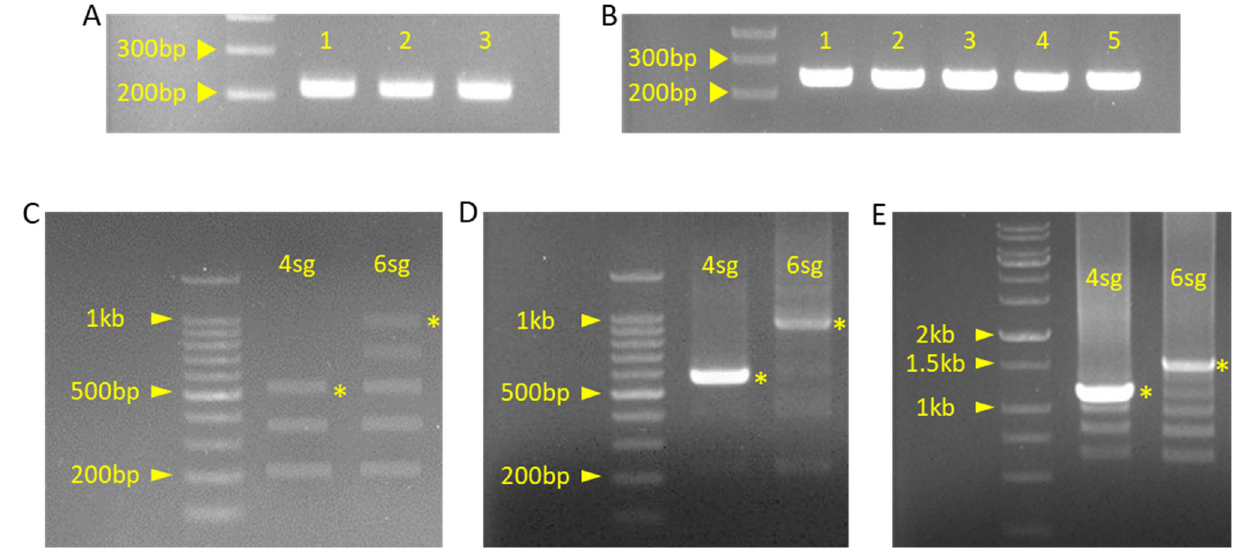
Figure 8. Gel picture of PCR or ligation products. ( A ) Product of insert fragment PCR for pBAtC_4sg construction. Each fragment number indicates a sequential order. 1: ‘g1g2’ primer set used fragment, 2: ‘g2g3’ primer set used fragment, 3: ‘g3g4’ primer set used fragment. ( B ) Product of insert fragment PCR for pBAtC_6sg construction. Each fragment number indicates sequential order. 1: ‘g1g2’ primer set used fragment, 2: ‘g2g3’ primer set used fragment, 3: ‘g3g4’ primer set used fragment, 4: ‘g4g5’ primer set used fragment, 5: ‘g5g6’ primer set used fragment. ( C ) Product of ligated insert fragment by Golden Gate reaction. ( D ) Product of ligated insert PCR of pBAtC_4sg and pBAtC_6sg. ( E ) Product of pBAtC_4sg, 6sg colony PCR. Yellow asterisk indicated by the expected band is the expected